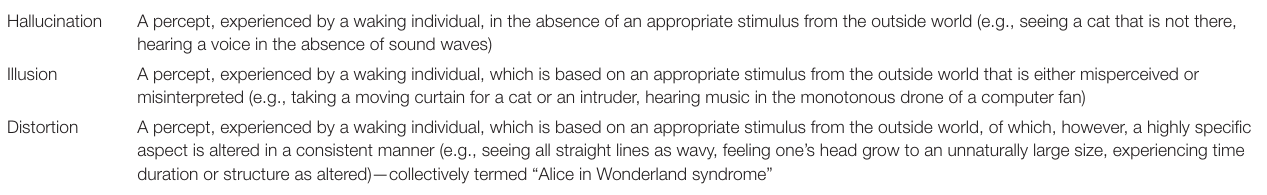
TABLE 1 | Definitions of the three main classes of misperception [adapted from (19)].